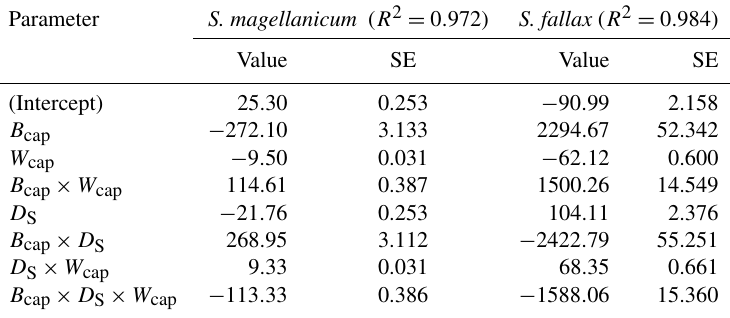
Table B2. Parameter estimates of the linear model for the log 10 -transformed capitulum water potential ( h ) for S. fallax and S. magellanicum . The estimated value, the standard error (SE), and the test statistics ( p values) are given for the predictors of the models. The predictors are the capitulum biomass ( B cap ), the capitulum density ( D S ), the capitulum water content ( W cap ), the interaction of the capitulum biomass and water potential ( B cap × W cap ), the interaction of the capitulum biomass and capitulum density ( D S × W cap ), the interaction of the capitulum density and water potential ( D S × W cap ), and the interaction of the capitulum biomass, capitulum density, and water potential ( B cap × D S × W cap ). All coefficient values are significantly different from zero ( p < 0 . 001). Parameter S. magellanicum ( R 2 = 0 . 972)